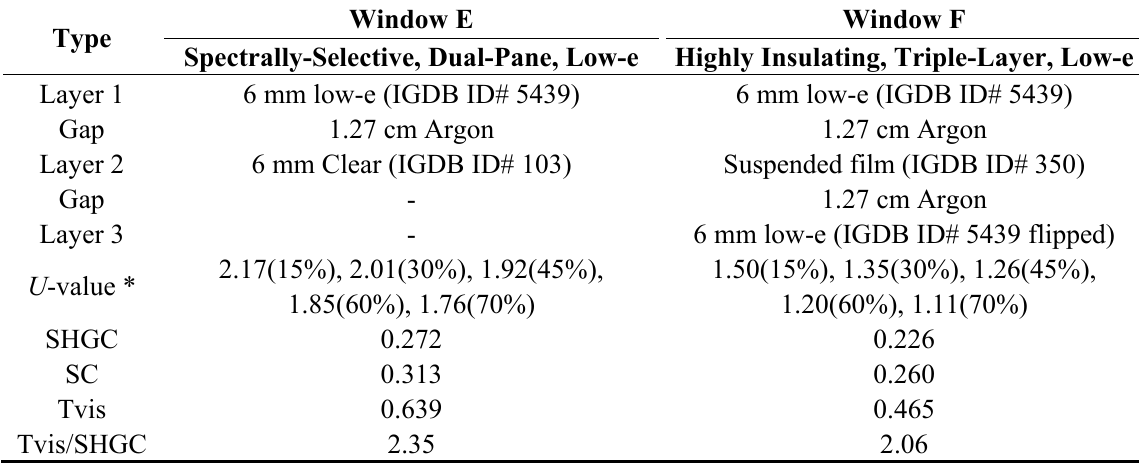
Table 5. Advanced window